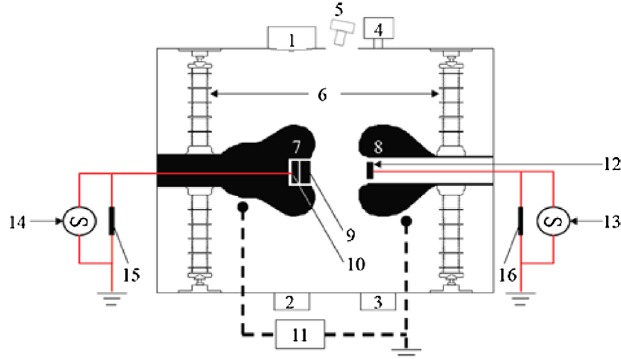
FIG. 1. Schematic diagram of experimental setup of